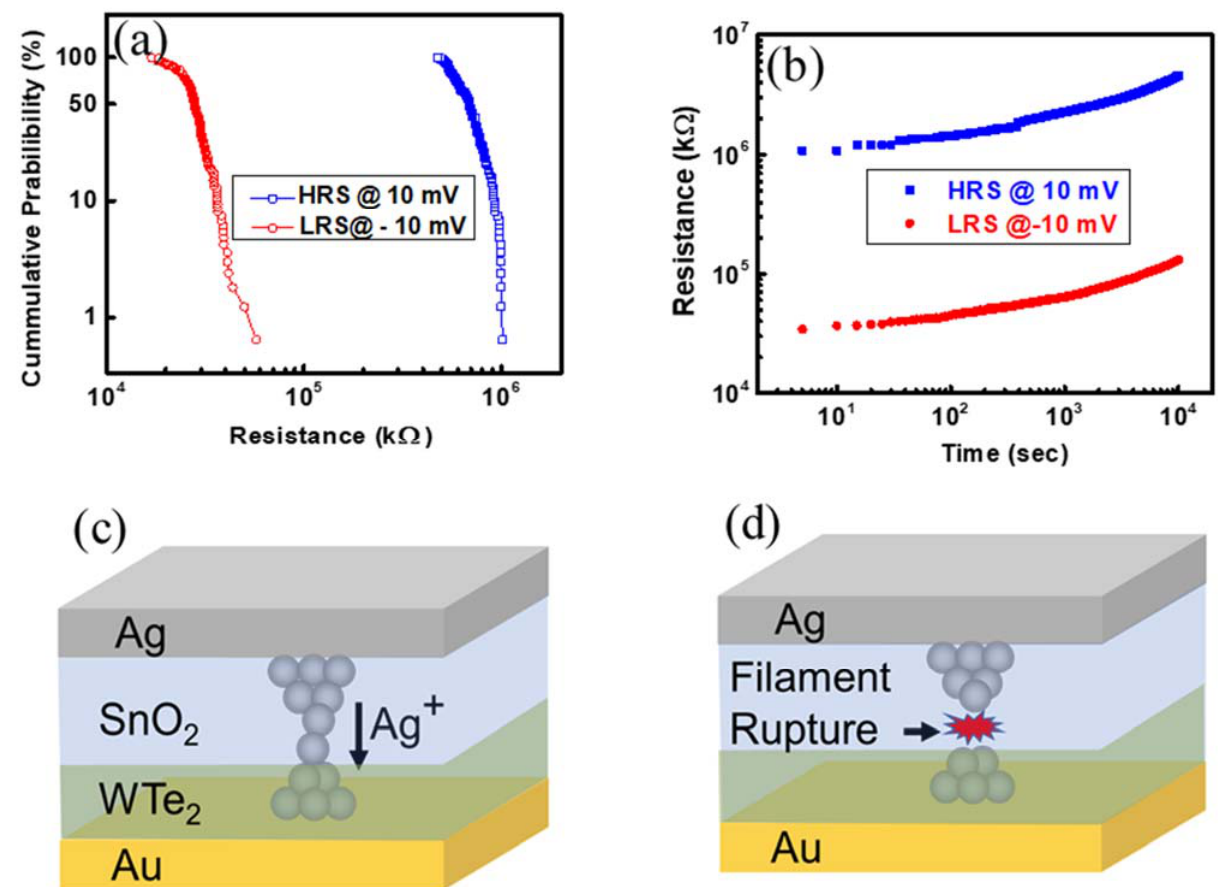
Figure 4. ( a ) The statistical distributions of the resistances of the Ag/SnO 2 /WTe 2 /Au stack memory device under consecutive DC I-V sweep. ( b ) Retention characteristics over 10 4 s for resistance states. ( c ) The filament formation under the applied voltage bias is due to the diffusion and stacking of the Ag ions. ( d ) The filament rapture state when an opposite polarity is applied to SET the device.